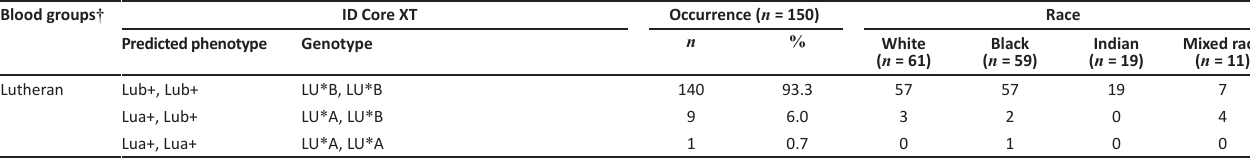
TABLE 1: (Continues...): Percentage occurrence of the ID CORE XT predicted phenotypes and genotypes for 150 South African blood donors genotyped at the South African National Blood Service Immunohaematology Reference Laboratory from January 2015 to August 2016. Blood groups † ID Core XT Occurrence ( n = 150) Race Predicted